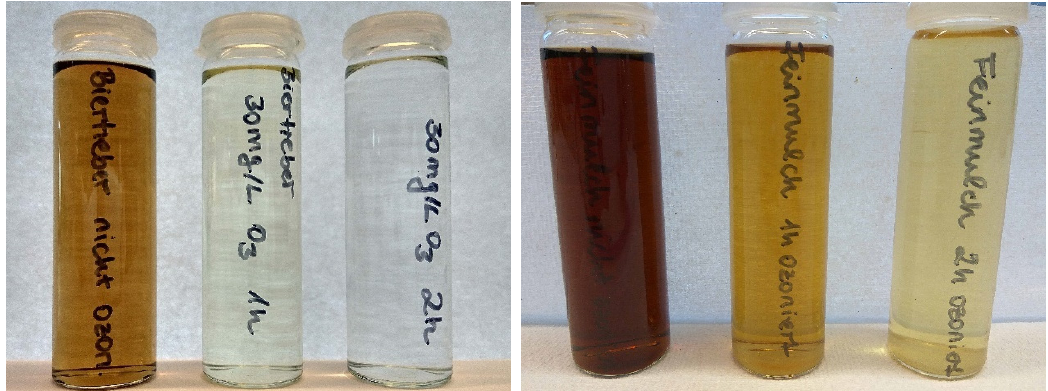
Figure 8. Effect of ozonation on pre-treated HTC spent grains PW ( left ) and fine mulch PW ( right ).